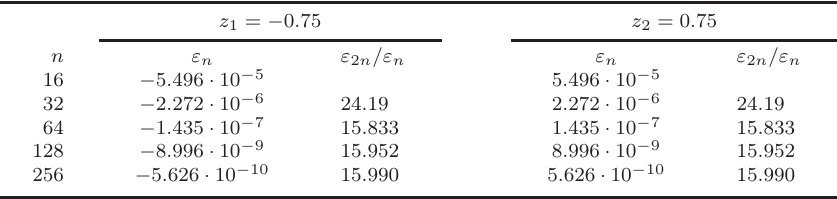
Table 2. Numerical results for y ( x ) = sin x , ε n = S ( z i ) − y ( z i ) , i = 1 , 2 . z 1 = − 0 . 75 z 2 = 0 . 75